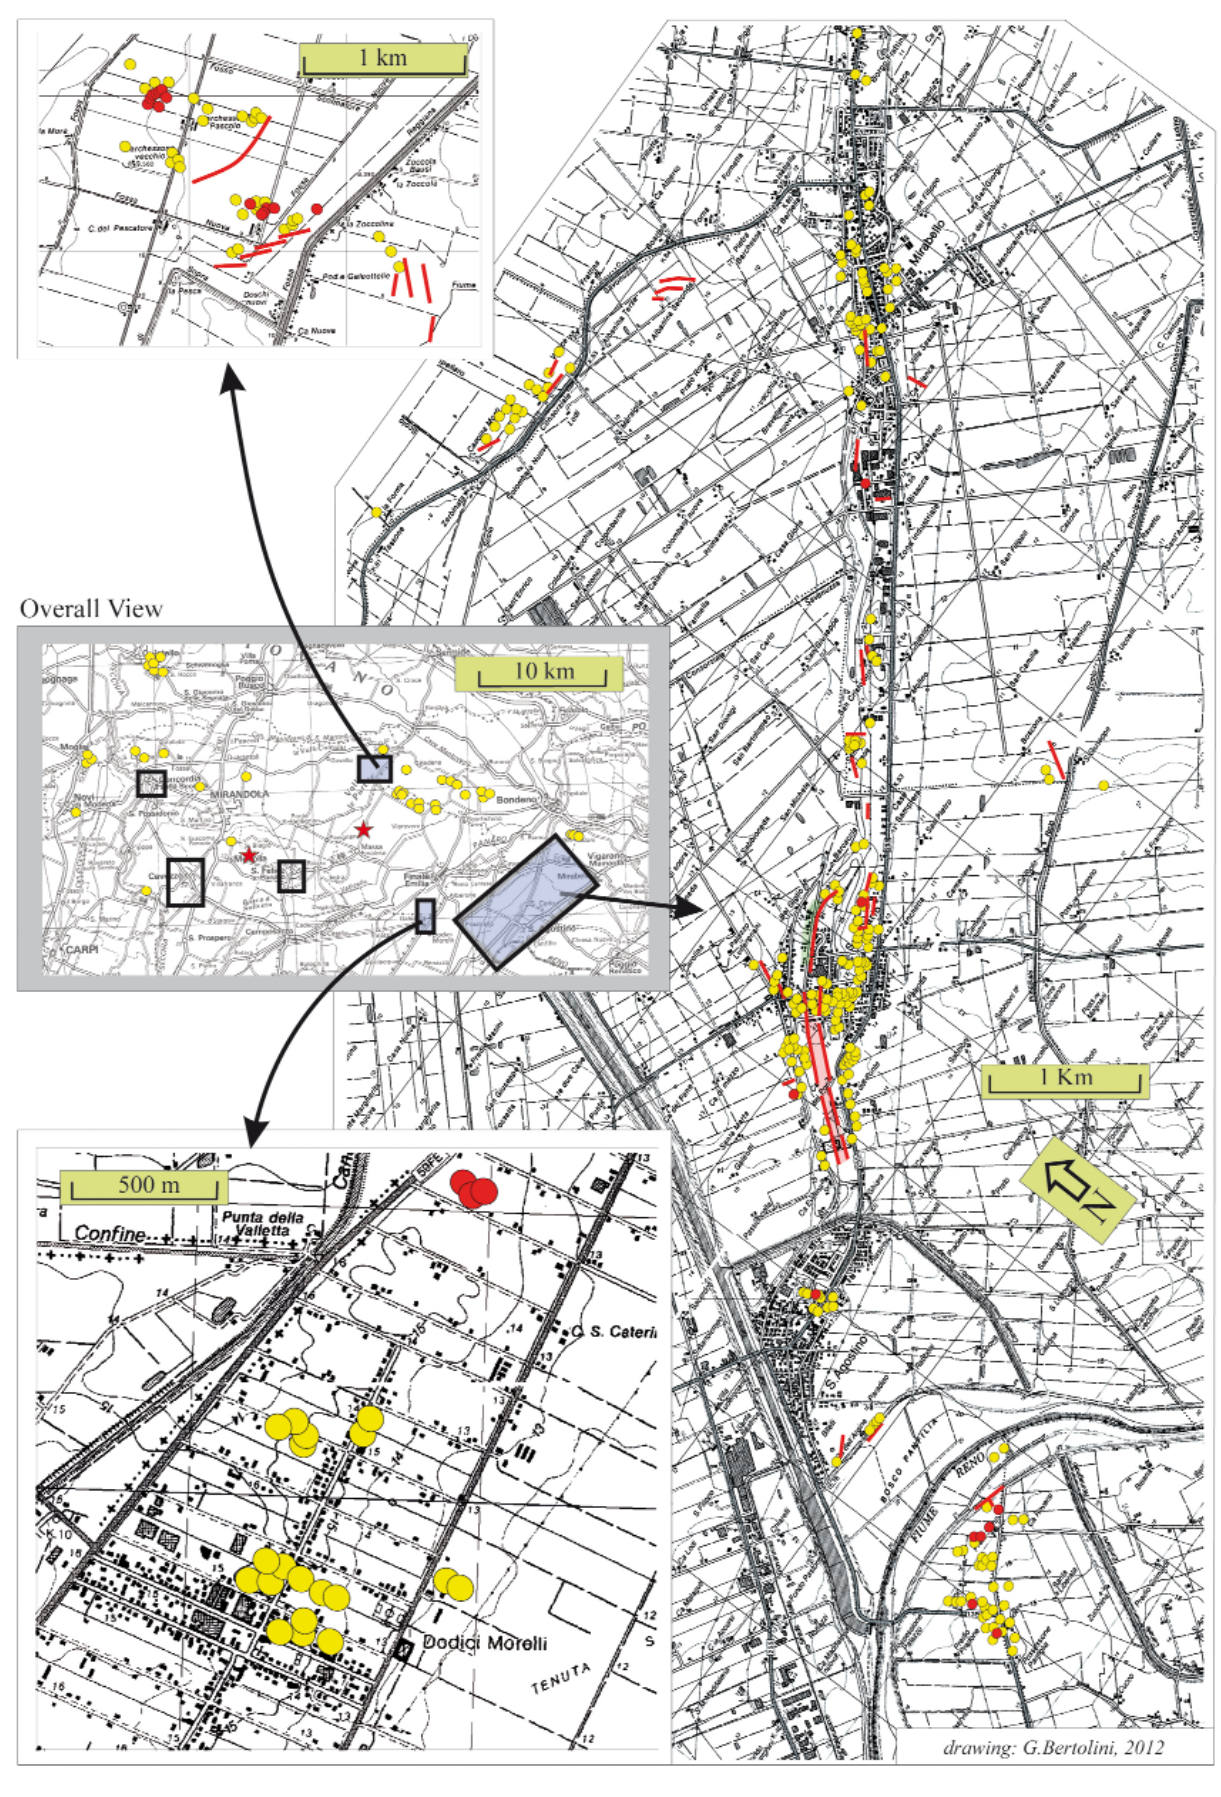
Figure 2b. Simplified maps of the observed geological effects. For symbols see